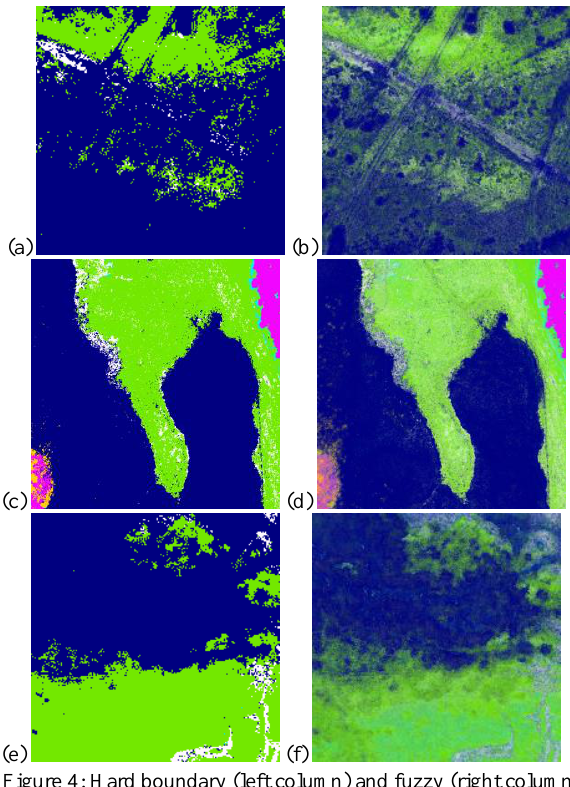
Figure 4: Hard boundary (left column) and fuzzy (right column) visualizations of the same area, showing clear linear features in (a, b);a large area covered by equal mix of two classes, suggesting the need to introduce a new class (c, d); and gradual transitions between several classes (e, f), all hardly detectable in the corresponding hard boundary